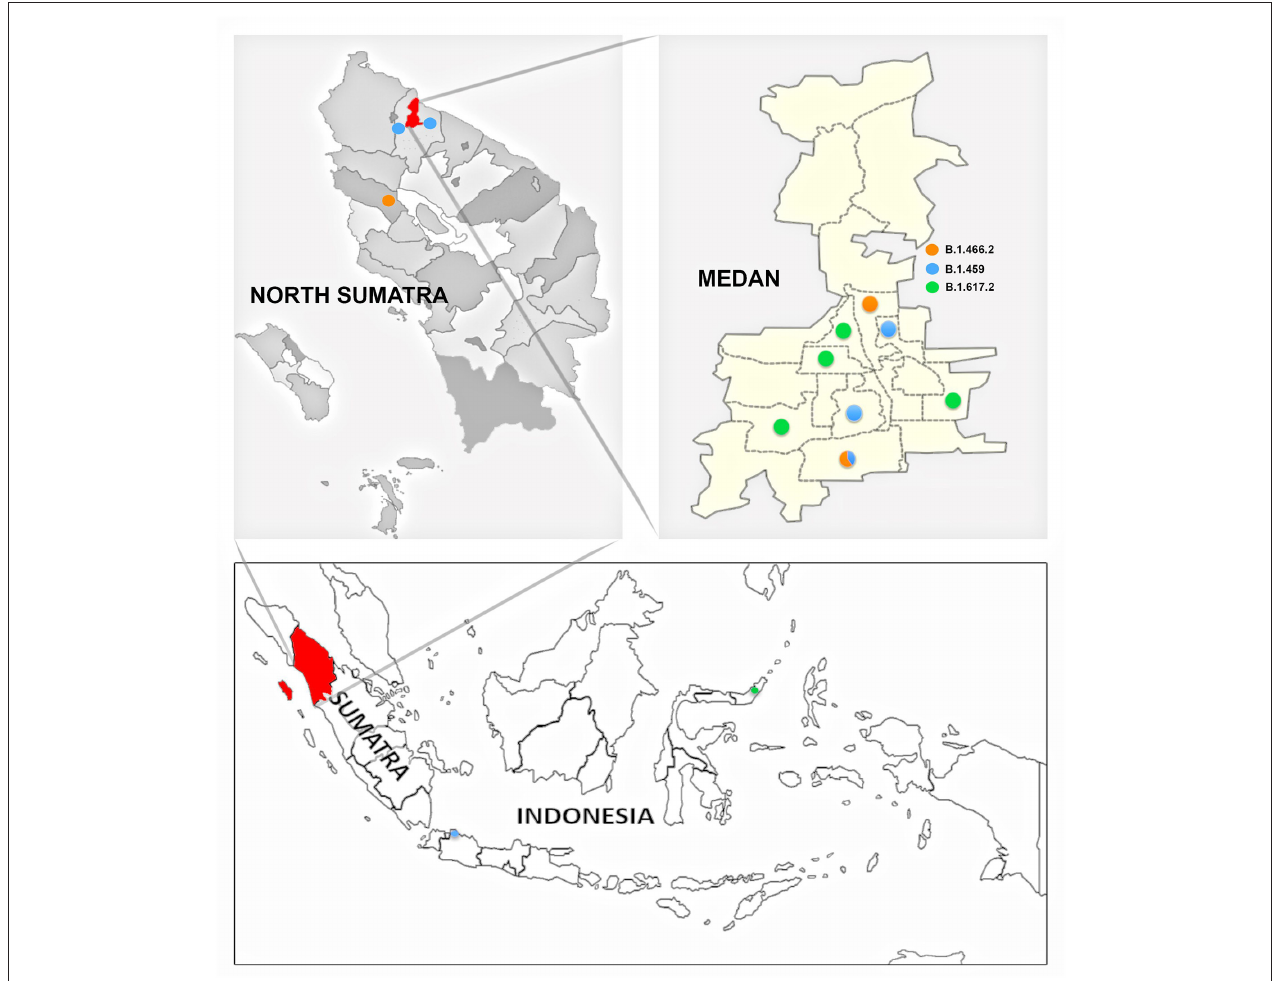
FIGURE 4 | Distribution of SARS-CoV-2 variants by area of origin within or outside medan municipality. Figure legend: B.1.459 (blue); B.1.466.2 (orange); B.1.617.2